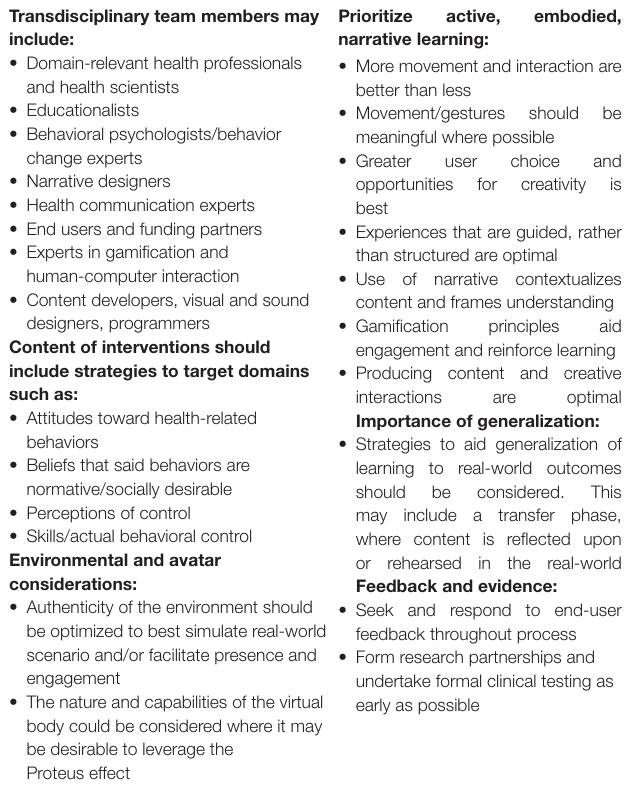
TABLE 1 | Key points for developing education and self-management interventions in virtual reality. Transdisciplinary team members may